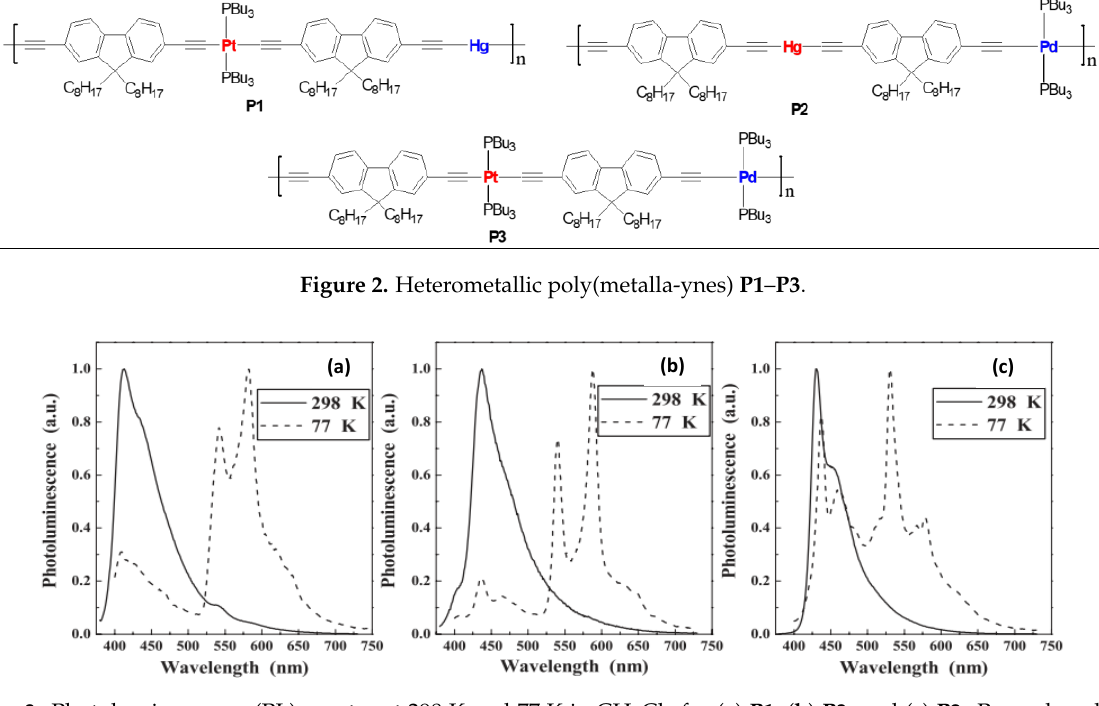
Figure 3. Photoluminescence (PL) spectra at 298 K and 77 K in CH 2 Cl 2 for ( a ) P1 , ( b ) P3 , and ( c ) P2 . Reproduced with permission from ref. [47].